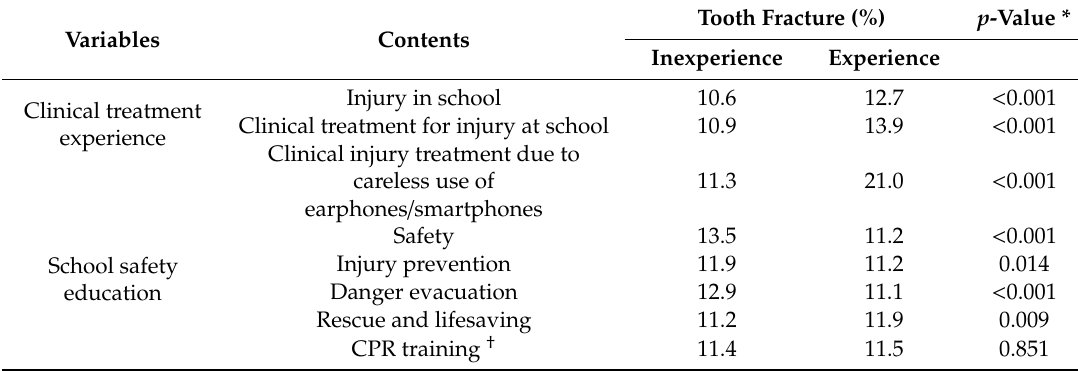
Table 4. Tooth fracture experience in the past 12 months by clinical treatment due to injury in